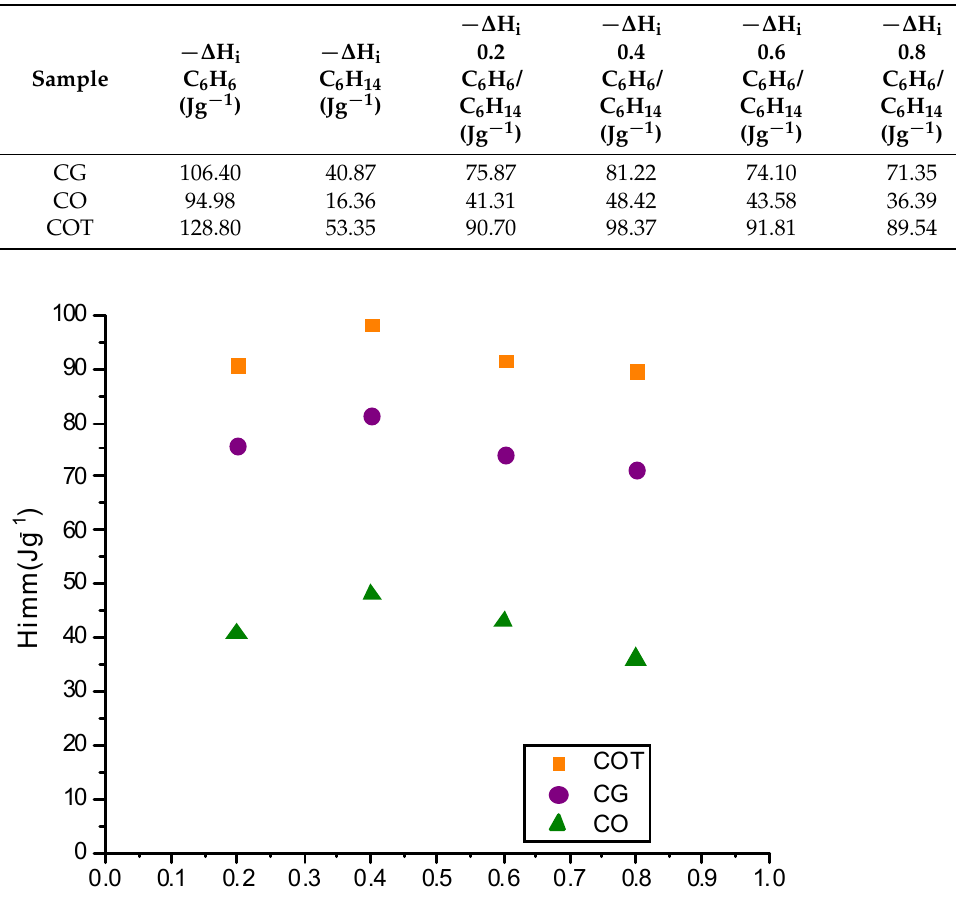
Table 2. Enthalpies of immersion of CG, CO and COT in pure liquids and in binary mixtures (benzene solute, hexane solvent) at concentrations between 0.2 and 0.8 mole fraction.